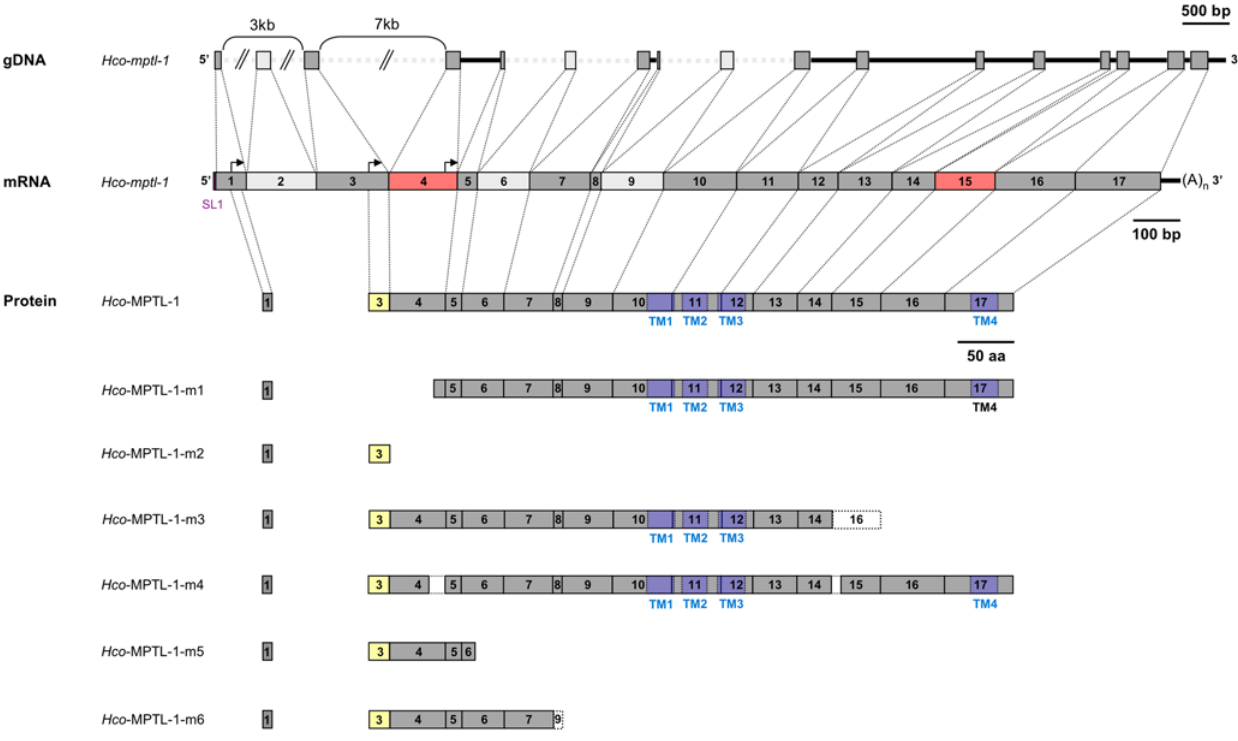
Figure 4. The Hco-mptl-1 locus, mRNA and protein (top) and mis-splicing mutations in the AAD mutants (bottom). Exons are represented by boxes, start codons by arrows. The 5 9 region of the genomic DNA is not drawn to scale (double parallel bars). No hits were found in the H. contortus genome project for the exons and introns shown in clear grey. The spliced leader is shown in violet and mis-spliced exons in red. The signal peptide is shown in yellow and the predicted transmembrane domains (TM) in blue.